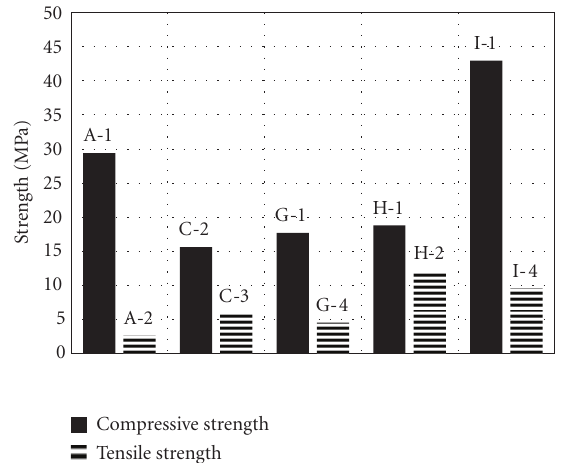
Figure 4: Compressive and splitting tensile strength results for individual